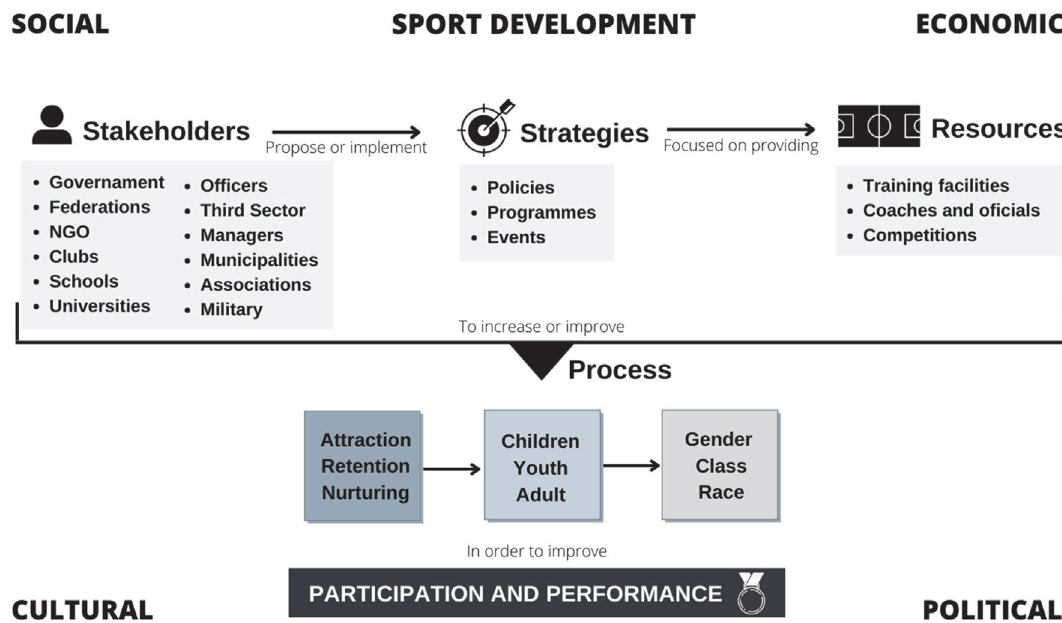
Figure 2 - Summary of the aspects investigated by the studies that can foster the development of the